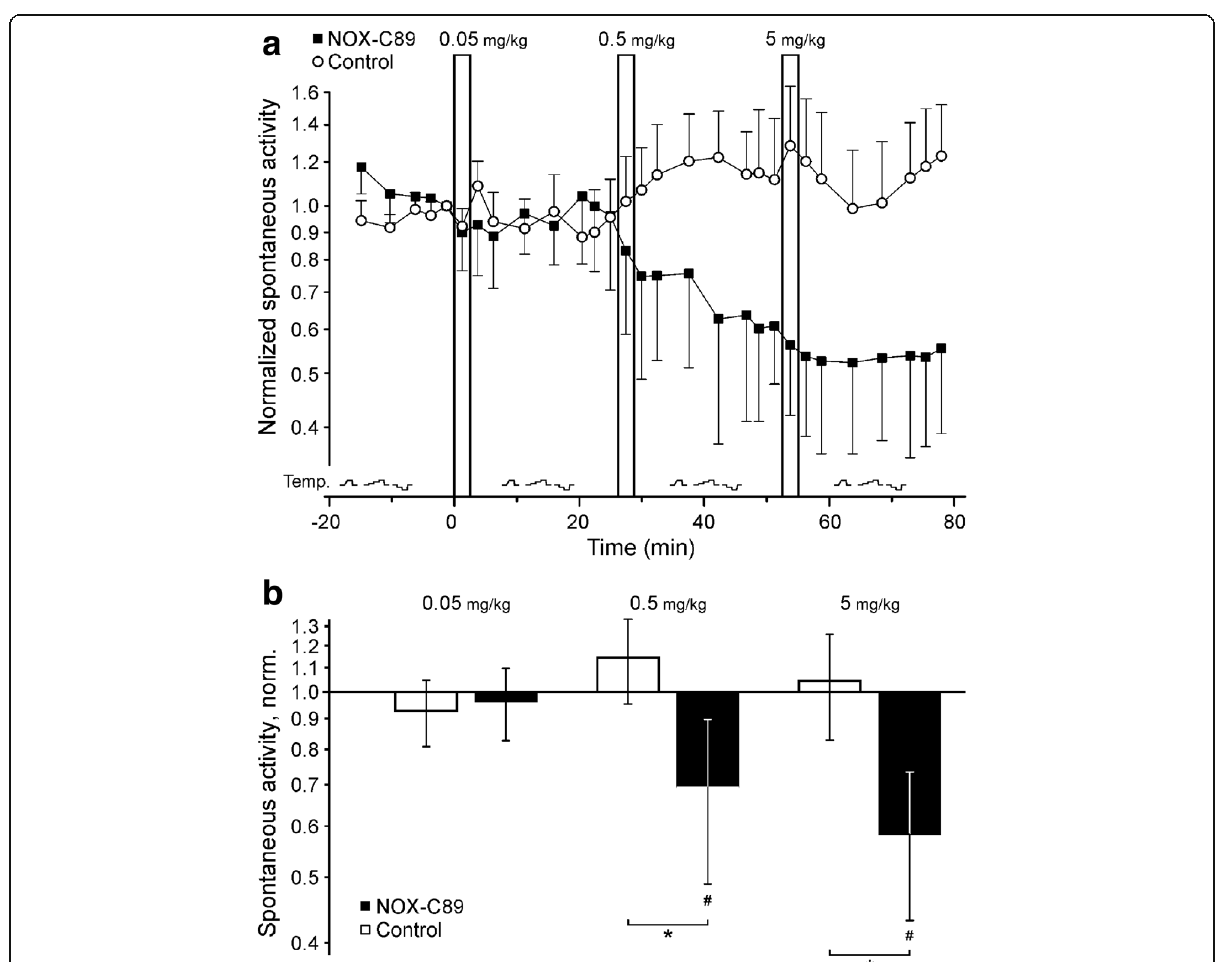
Fig. 1 Anti-CGRP L -aptamer NOX-C89 reduces spontaneous neuronal activity. a Normalized activity of spinal trigeminal neurons. After infusion of NOX-C89, spontaneous activity was reduced. In contrast, infusion of the control L -aptamer did not alter neuronal activity. For both groups eight separate experiments were performed, symbols represent activity per 150 s. Note the longer intervals used for thermal testing, the heat and cold protocols are visualized at the bottom. b Twenty minutes after the infusion of NOX-C89 0.5 mg/kg and 5 mg/kg the spontaneous neuronal activ- ity was reduced, both in comparison to baseline activity at the beginning of the experiment (7.5 min period before the first injection, # p < 0.05) and to the control group (* p < 0.05). Data are mean ±